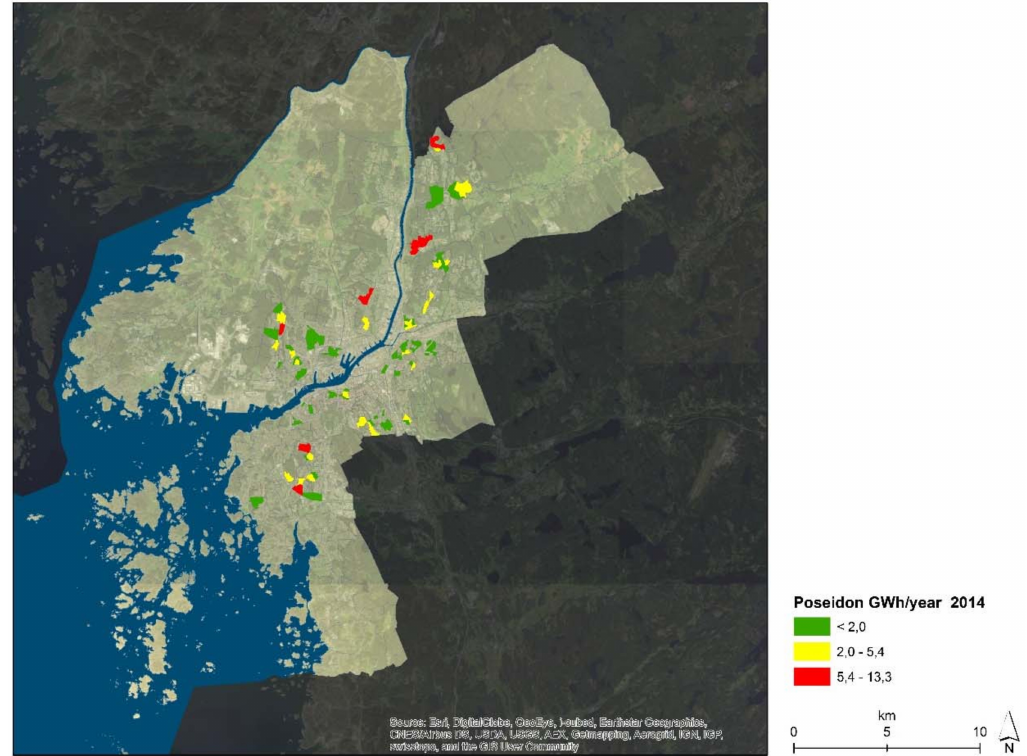
Figure 5. Density map showing measured energy use for buildings owned and managed by Poseidon, a subsidiary of the municipal housing company Framtiden